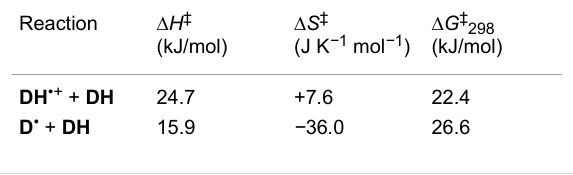
Table 2: Activation parameters for the self-exchange reactions of TIPA, as obtained from the Eyring plots of Figure 4.